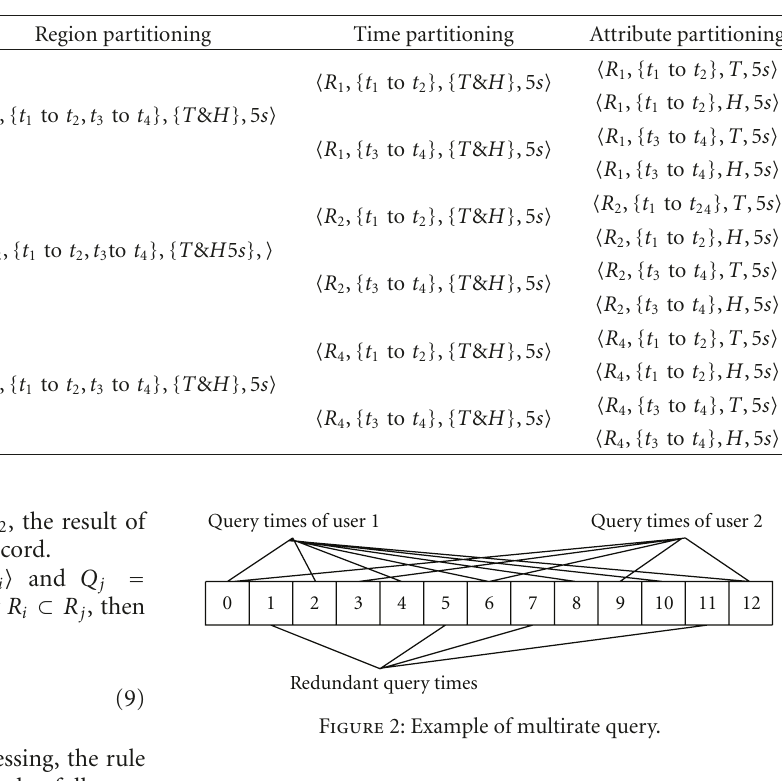
Table 1: Process of query partitioning.